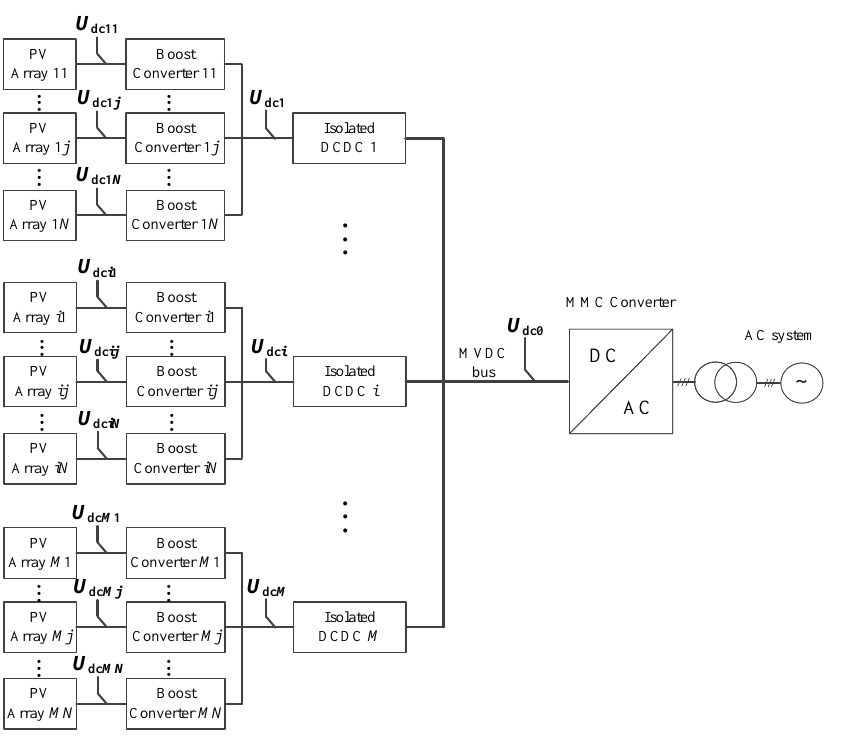
Figure 1. PhotoVoltaic (PV) integration system with VSC-MVDC technology.